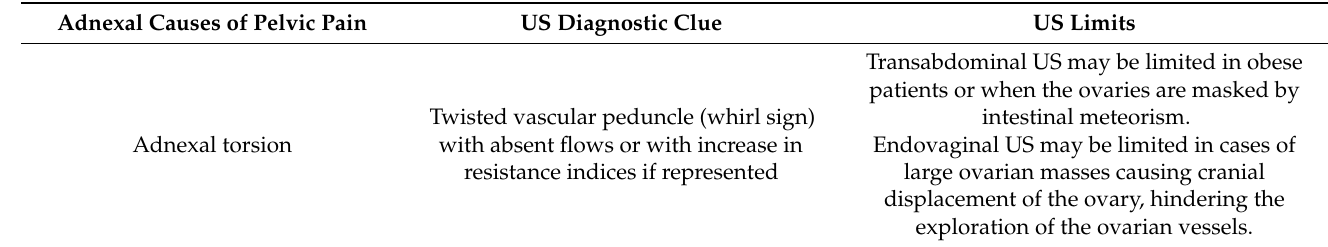
Table 3. Adnexal torsion US diagnostic